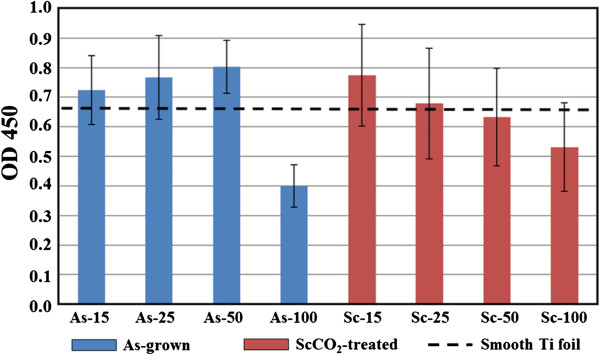
Optical densities (QD) measured after the culture of human fibroblast cells. On the as-grown and ScCO2-treated TiO2 nanotubes of different diameters.